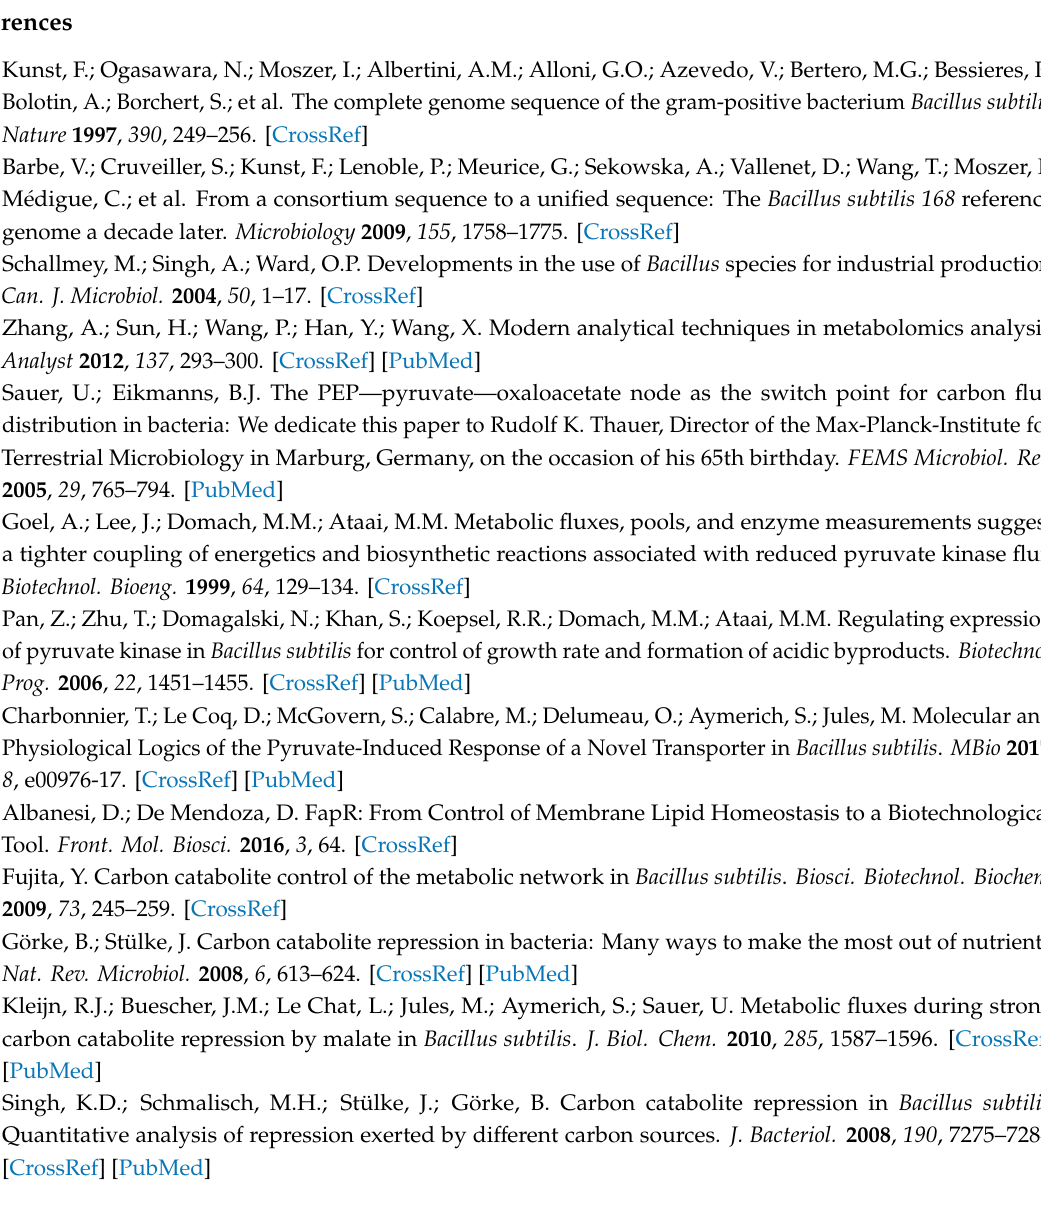
Table S1: OD of wt and ∆ pyk at 600 nm during growth in M9GlcPyr at 37 ◦ C and 300 rpm, Table S2: Physiological parameters (growth rate, acetate, acetoin, and 2,3-butanediol maximum concentration) of wt and ∆ pyk of four replicates, Table S3: Intracellular metabolome data of B. subtilis wt and ∆ pyk. Mean of the relative amount of intracellular metabolites, SD values, and FC of four biological replicates of wt and ∆ pyk, Unpaired t -tests were also determined for each metabolite, where p -value represents the statistical result, Figure S1: Experimental workflow for metabolome analysis, Table S4: MS source parameters used during amino acids